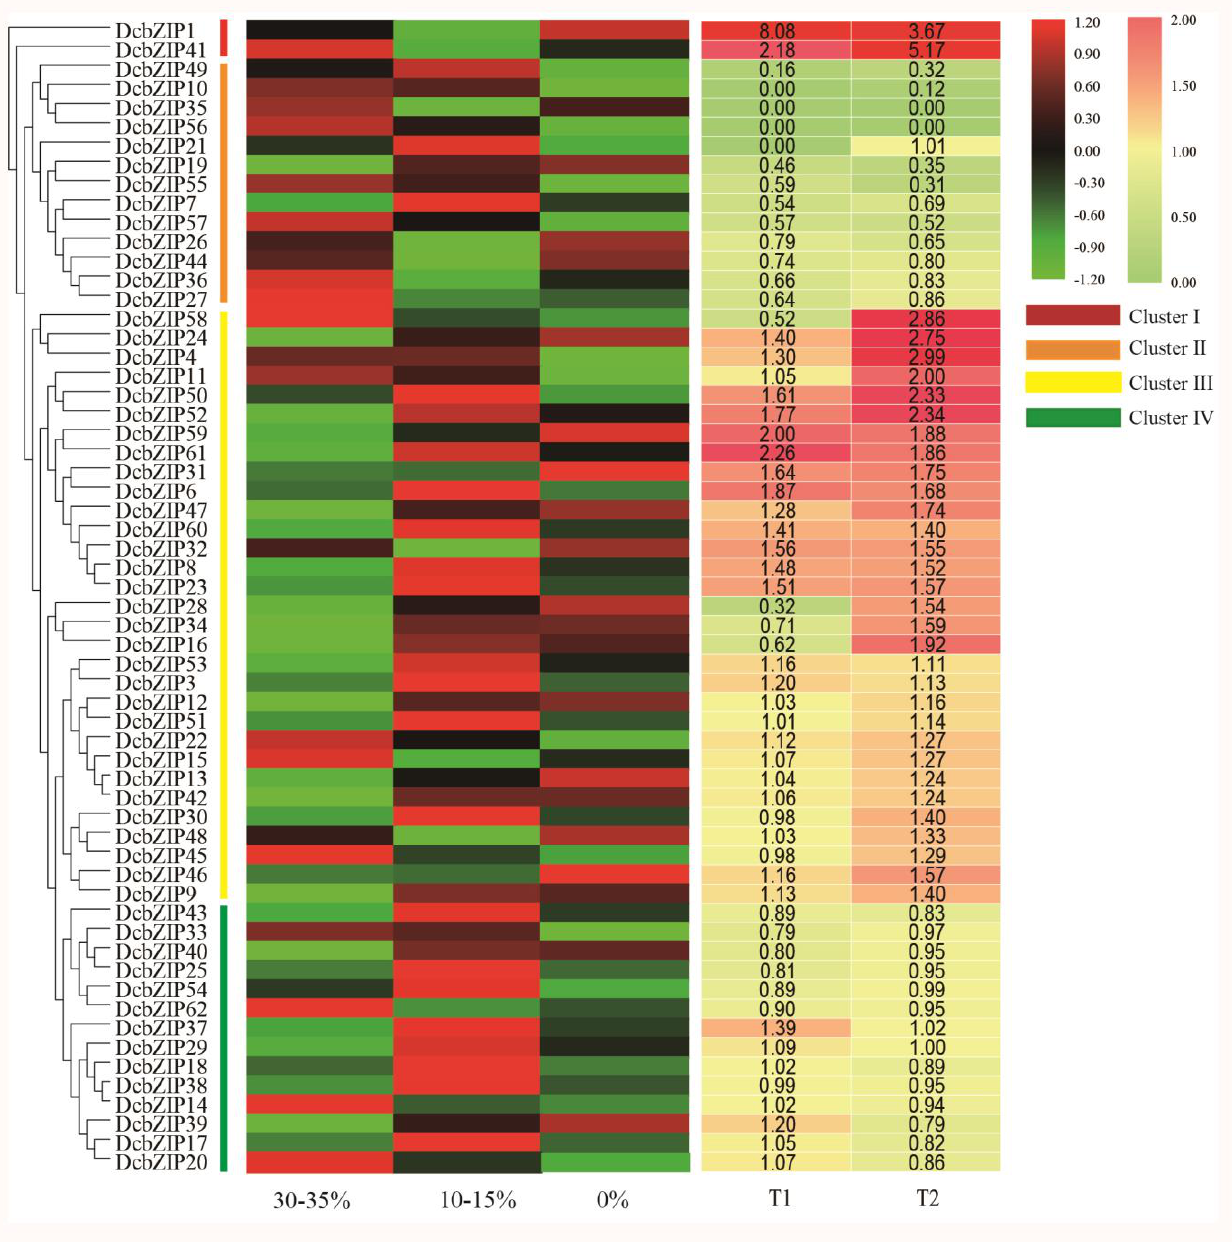
Figure 5. The expression patterns of DcbZIP genes evaluated by RNA-seq. The left heatmap shows the expressions of DcbZIP genes under different volumetric water contents of base material. Data were normalized relative to each gene’s mean expression value across all treatments and log2-transformed. TPM (transcripts per million) values were used to create heat map showing the expression of DcbZIP genes. The expression levels range from low expression (green) to high expression (red). The right heatmap shows the TPM ratios, with high ratios in light orange and low ratios in cyan. T1 was equal to the TPM of 10–15% divided by the TPM of 30–35%, and T2 was equal to the TPM of 0% divided by the TPM of 30–35%. Ranges of 30–35%, 10–15% and 0% represent the volumetric water content of the base material declining to ~30–35%, ~10–15% and ~0%,